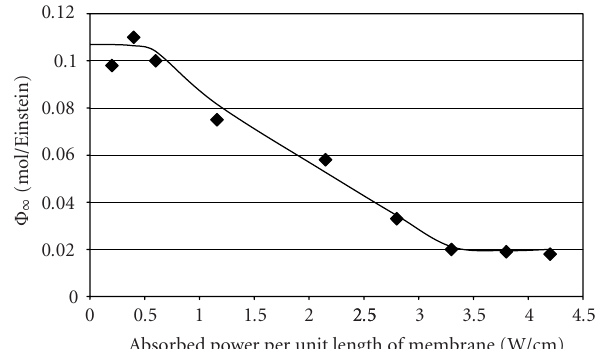
Figure 4: Quantum e ffi ciencies Φ ∞ (mol/Einstein), extrapolated by (1) (see Section 2), at “infinite” concentration of substrate for methanoic acid in aqueous solution as a function of absorbed power per unit length of irradiated photocatalytic membrane expressed as Wcm − 1 . Data taken from [26].